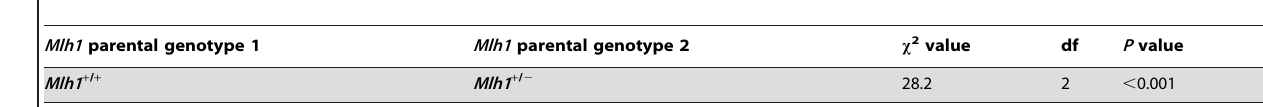
Table 1. x 2 and p value analyses of intergenerational GAA repeat transmissions.